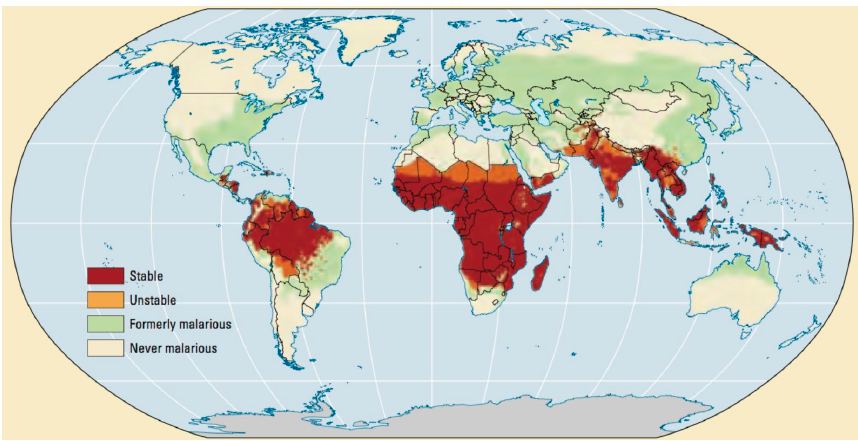
Figure 1. Severity of malaria prevalence in 2009 [9].